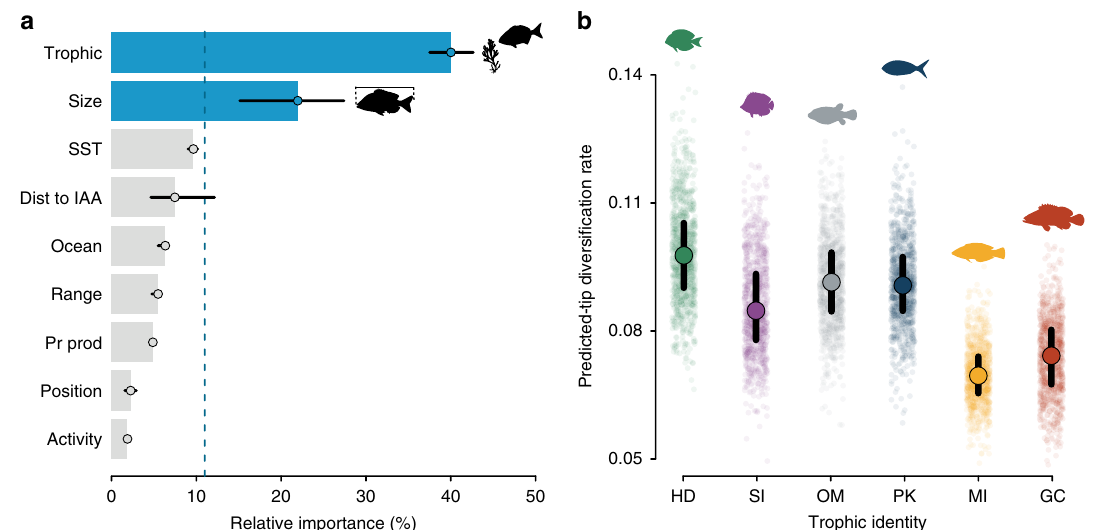
Fig. 2 Ecological and geographical factors driving reef fi sh tip diversi fi cation patterns. a Mean relative importance (%) of explanatory variables based on an extreme gradient boosting model. Blue bars show variables above chance expectation (dashed line). Black lines represent importance quantiles (25% and 75%) derived from 1000 model bootstraps. Trophic: trophic identity; Size: maximum body length; SST: sea surface temperature; Dist to IAA: distance to the Indo-Australian-Archipelago; Ocean: oceanic basin; Range: geographic range; Pr prod: primary productivity; Position: position in the water column; Activity: circadian activity period (see Methods). b Predicted tip diversi fi cation rates per trophic group. In this analysis, all other continuous variables are kept at their mean values and categorical variables in the most common category. HD: herbivores/detritivores (green); SI: sessile invertivores (purple); OM: omnivores (gray); PK: planktivores (blue); MI: mobile invertivores (yellow); GC: generalized carnivores (red). Semi-transparent dots are bootstrapped predictions ( n = 1000), with larger points representing median values with respective 25% and 75% prediction quantiles (black lines). Fish silhouettes were sourced from Schiettekatte et al. 91 . Source data are provided as a Source Data fi